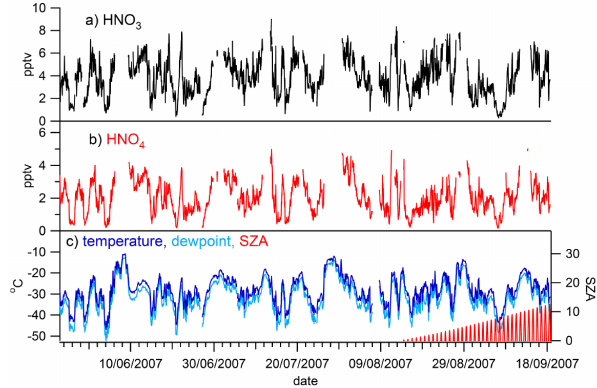
Figure 1. Time series of (a) HNO 3 , (b) HO 2 NO 2 , and (c) ambient temperature, dewpoint, and solar zenith angle (SZA) (hourly aver- ages) for the entire measurement period discussed in this paper, 24 May to 18 September 2007.